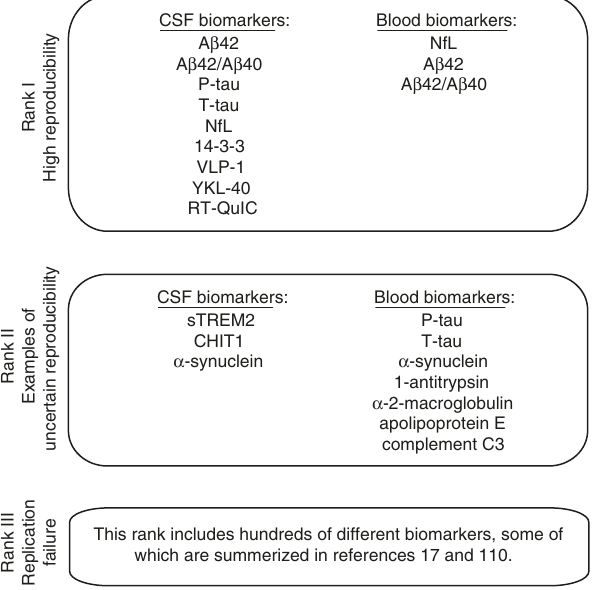
Fig. 3 Ranks of reproducibility. A brief summary with examples of fl uid biomarkers for neurodegenerative diseases, by their level of